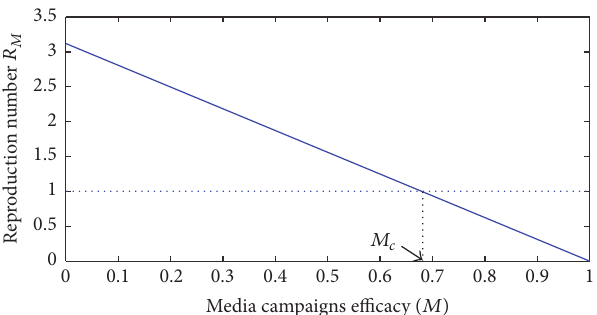
Figure 2: Time dependent reproduction number. The parameters values used for this plot are 𝜇 = 0.008 , 𝛽 = 0.2 , 𝜎 = 0.58 , 𝛾 = 0.845 , = 0.15 , 𝛿 = 0.6 , 𝑐 = 12 , 𝜔 = 4 × 10 −4 , 𝑝 = 0.85 , 𝜃 = 0.1 , 𝛿 1 2 = 9 × 10 −7 , 𝛼 = 2 × 10 −7 , 𝛼 = 5 × 10 −6 , 𝛼 = 8 × 10 −5 , 𝛼 = 10 −6 , 𝛼 1 2 3 4 5 𝜌 = 0.97 , and 𝜂 =